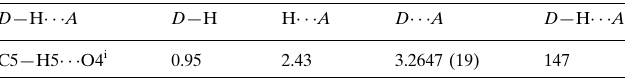
Hydrogen-bond geometry (A˚ , (cid:3)